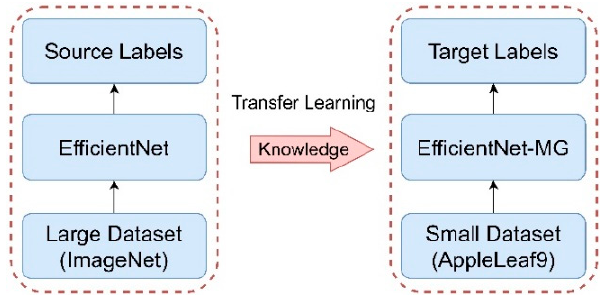
Figure 7. Transfer learning process.